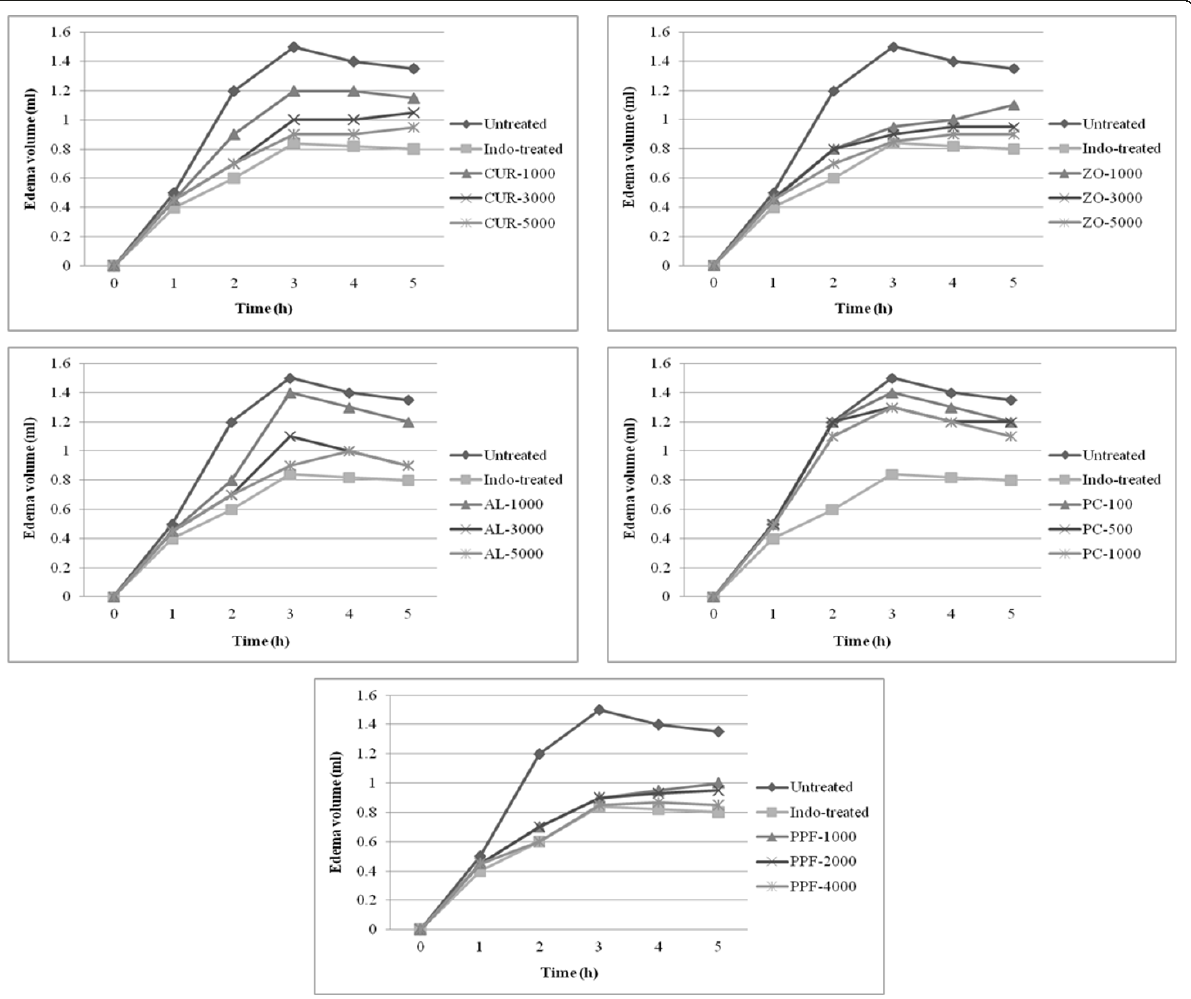
Figure 8 Inflammatory activity (represented by mean ± SEM change of edema volume in l -carrageenan-induced paw edema test) of CUR compound and extracts of ZO, AL, PC, and PPF at various dose levels, in comparison with untreated control and indomethacin (reference control) . Statistically significant difference by ANOVA, followed by post hoc scheffe test: CUR-treated group at low dose level vs. control group (p < 0.01). CUR-treated group at medium dose level vs. control group (p < 0.01). CUR-treated group at high dose level vs. control group (p < 0.01). Aspirin-treated group vs. control group (p <